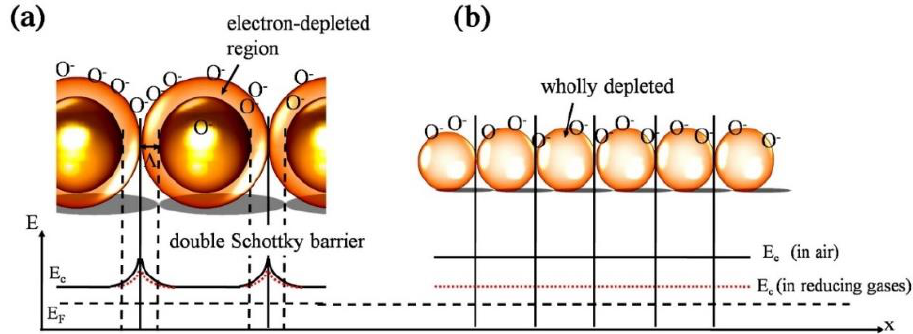
Figure 7. Sensing mechanism of SnO 2 QDs. ( a ) formation of double Schottky barriers; ( b ) energy levels in SnO 2 QDs when the grains are smaller than the thickness of the space charge layer [54].